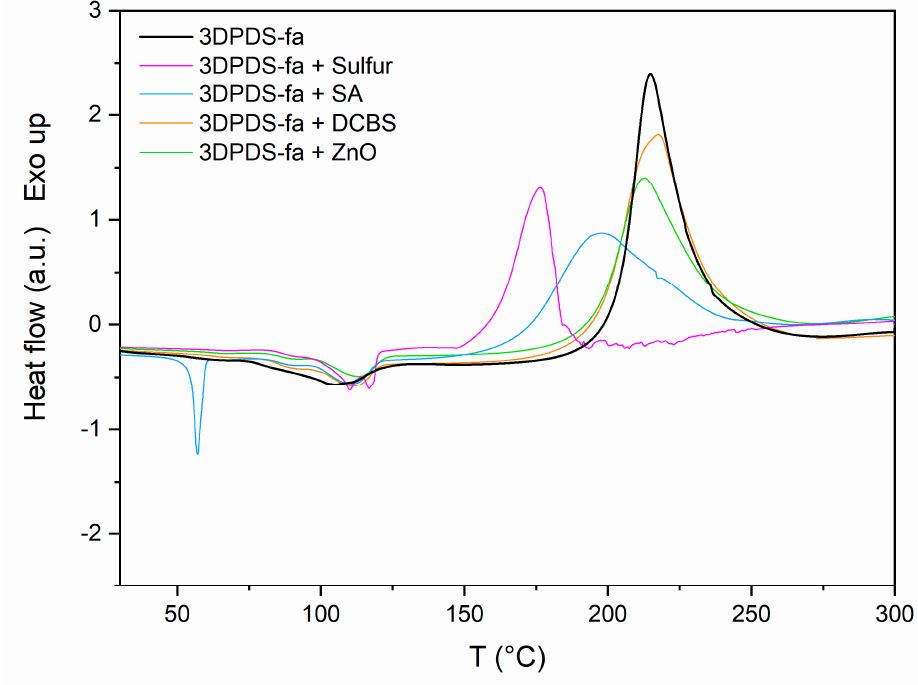
Figure A28. DSC thermogram of 3DPDS-fa with sulfur, DCBS, ZnO, and stearic acid.